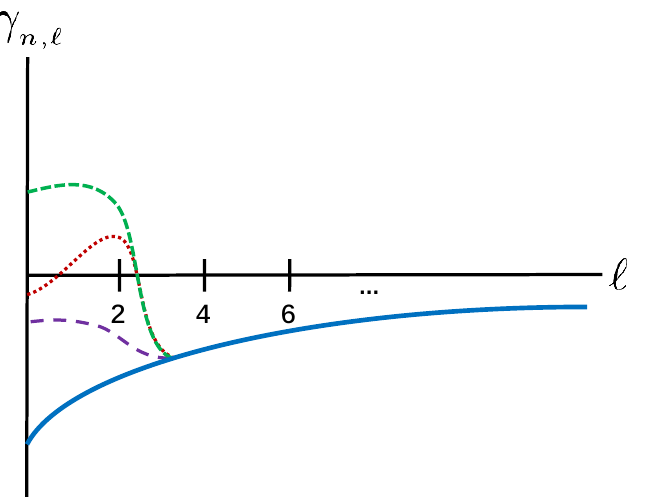
Figure 2. The schematic form of (cid:13) n;‘ in a large N CFT with a weakly coupled, local gravity dual, valid for all n . The contribution to (cid:13) n;‘ from individual single-trace operators O (cid:28);s is a negative, monotonic, convex function of ‘ for ‘ > s . In holographic CFTs with (cid:1) gap ! 1 , there is a (cid:12)nite number of such contributions, all with spin s (cid:20) 2, thus yielding the above behavior. For ‘ = 0 ; 2, various behaviors are possible, due to non-analytic